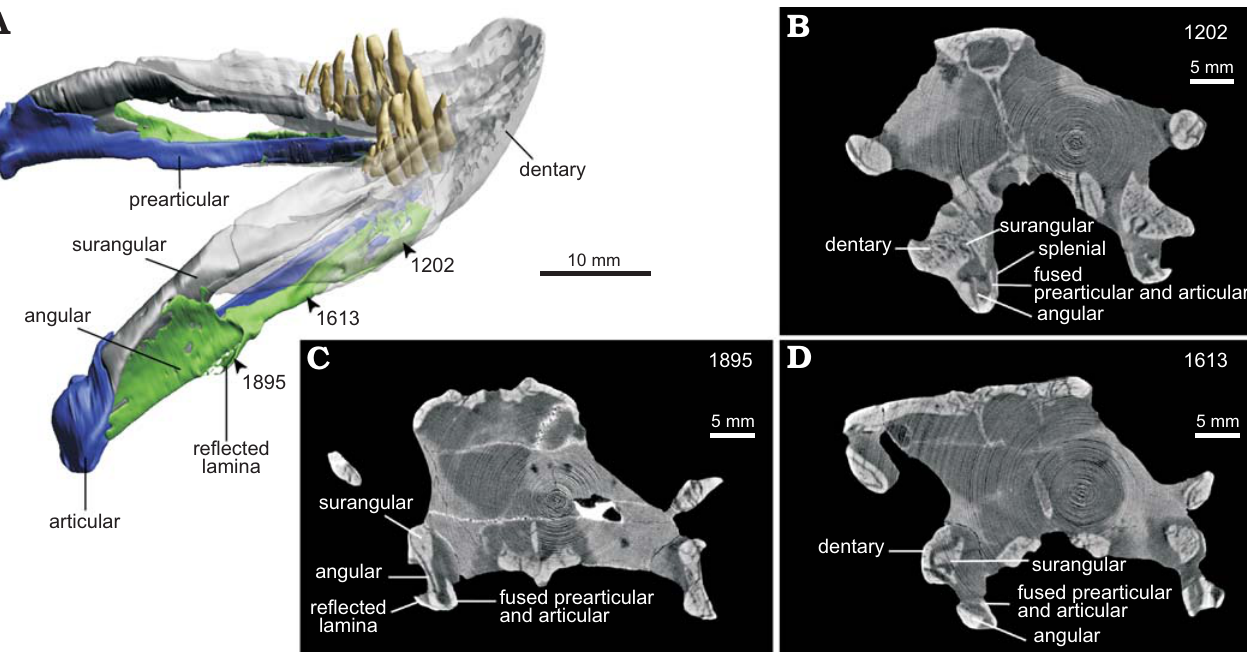
Fig. 6. The mandible of the non-mammalian synapsid Pristerodon mackayi Huxley, 1868 (MB.R.985) from the Late Permian of Biesjespoort, South Africa. A . Virtual reconstruction from neutron tomographic data. Note that the dentary is shown in transparent to provide insight into the internal structure. The arrows mark the positions and the number of the tomographic slices shown in B–D. B – D . Tomographic slices ( B , 1202; C , 1895; D , 1613) showing the internal structure of the mandible. Note that surangular, prearticular, and angular are not fused with the